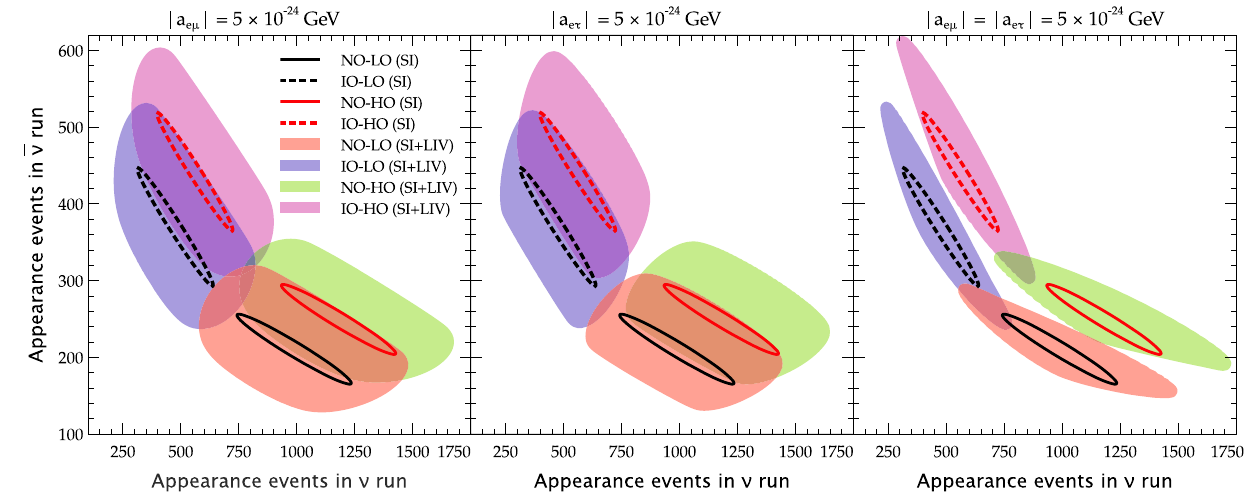
Fig. 2 Bi-event plots for DUNE. The standard interaction (SI) case is represented by the solid/dashed ellipses, which are obtained varying the standard CP phase δ in the range [− π,π ] . The colored blobs denote the presence of LIV on top of the SI. These blobs are generated vary- ing the CP phases: δ,ϕ e μ (left panel), δ,ϕ e τ (middle panel), δ,ϕ e μ , and ϕ e τ (right panel). In all the cases, CP phases are allowed to vary